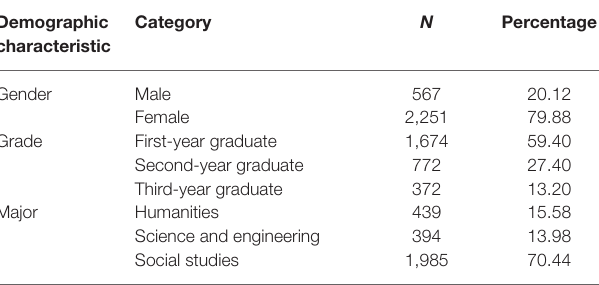
TABLE 1 | General demographic characteristics of respondents.